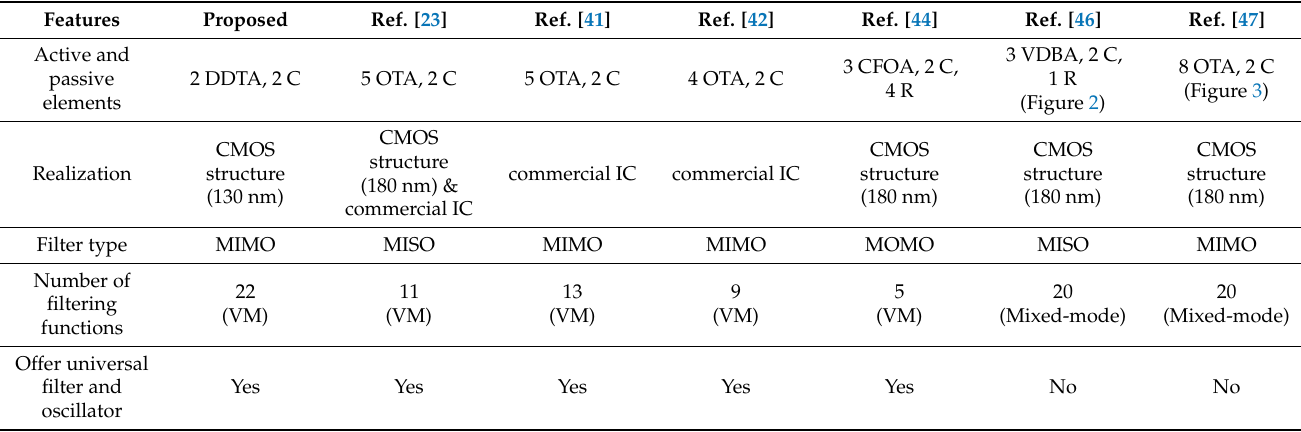
Table 5. Comparison table with other universal filters.